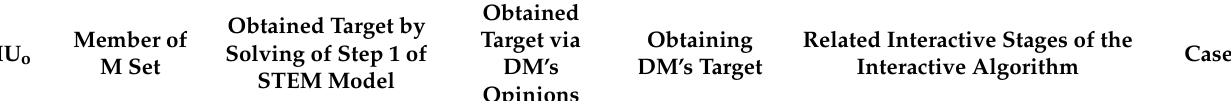
Interactive Algorithm